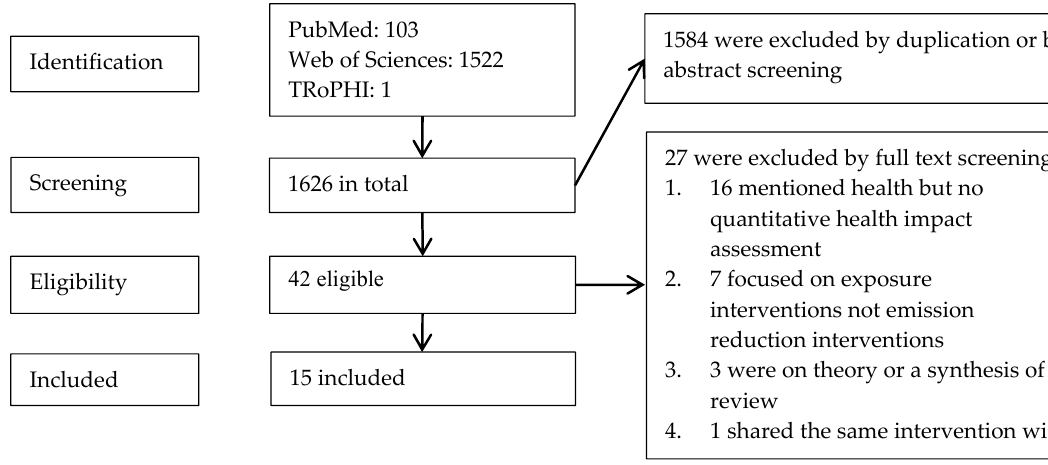
Figure 1. Flow chart of the searching and screening procedure.